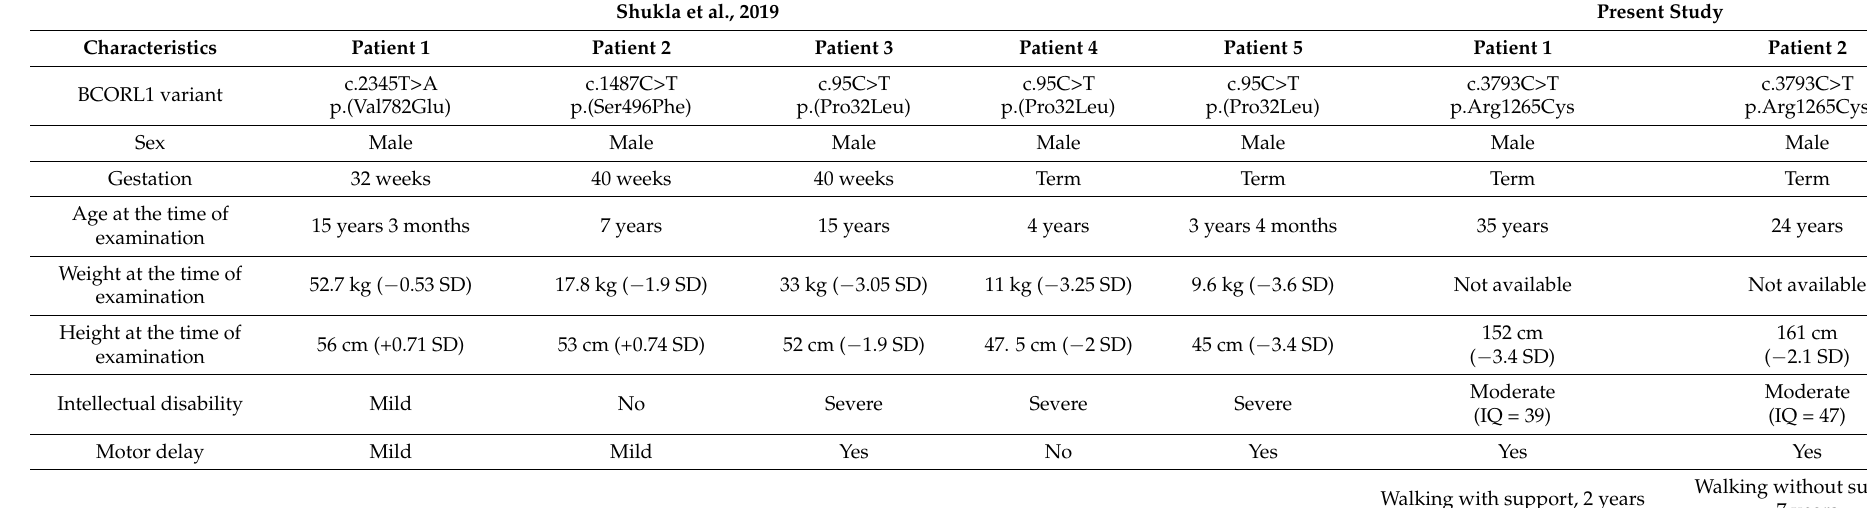
Table 1. Comparison of phenotypic and genotype details of patients (IV-2 and IV-7) with the previously published patients. Shukla et al.,